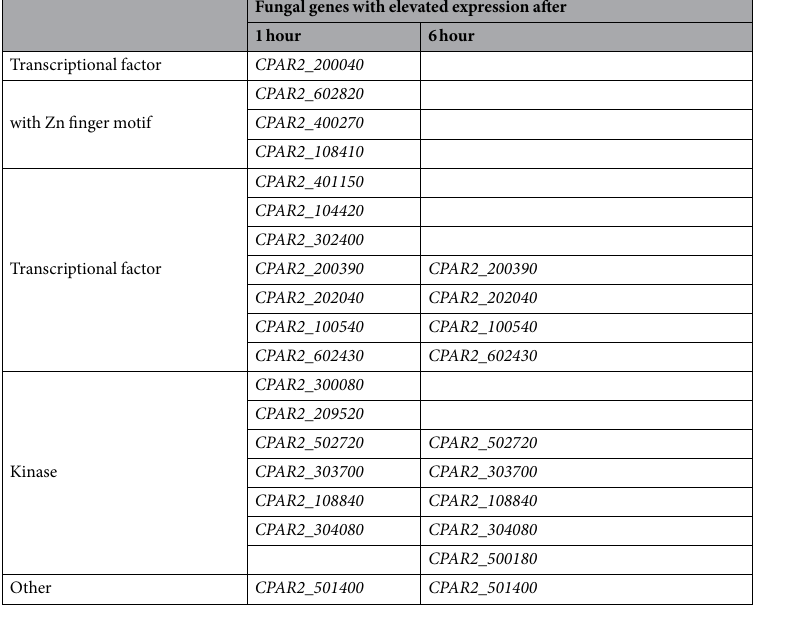
Table 1. Targets of the C. parapsilosis deletion mutant